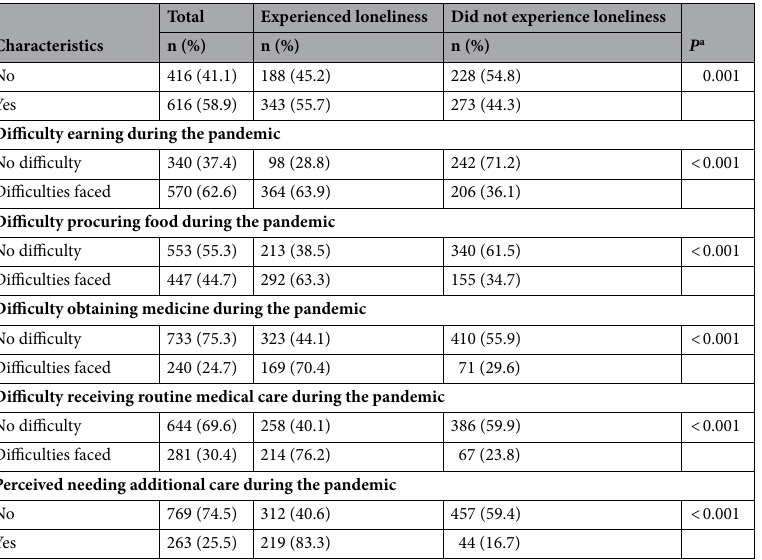
Table 1. Participants’ characteristics and bivariate analyses (N = 1032). a P value obtained from Chi-square test evaluating the differences between those who experienced and did not experience loneliness. b Without partner group includes divorced, separated and never married. c BDT stands for Bangladesh taka and 1 BDT ~ 84.7 US